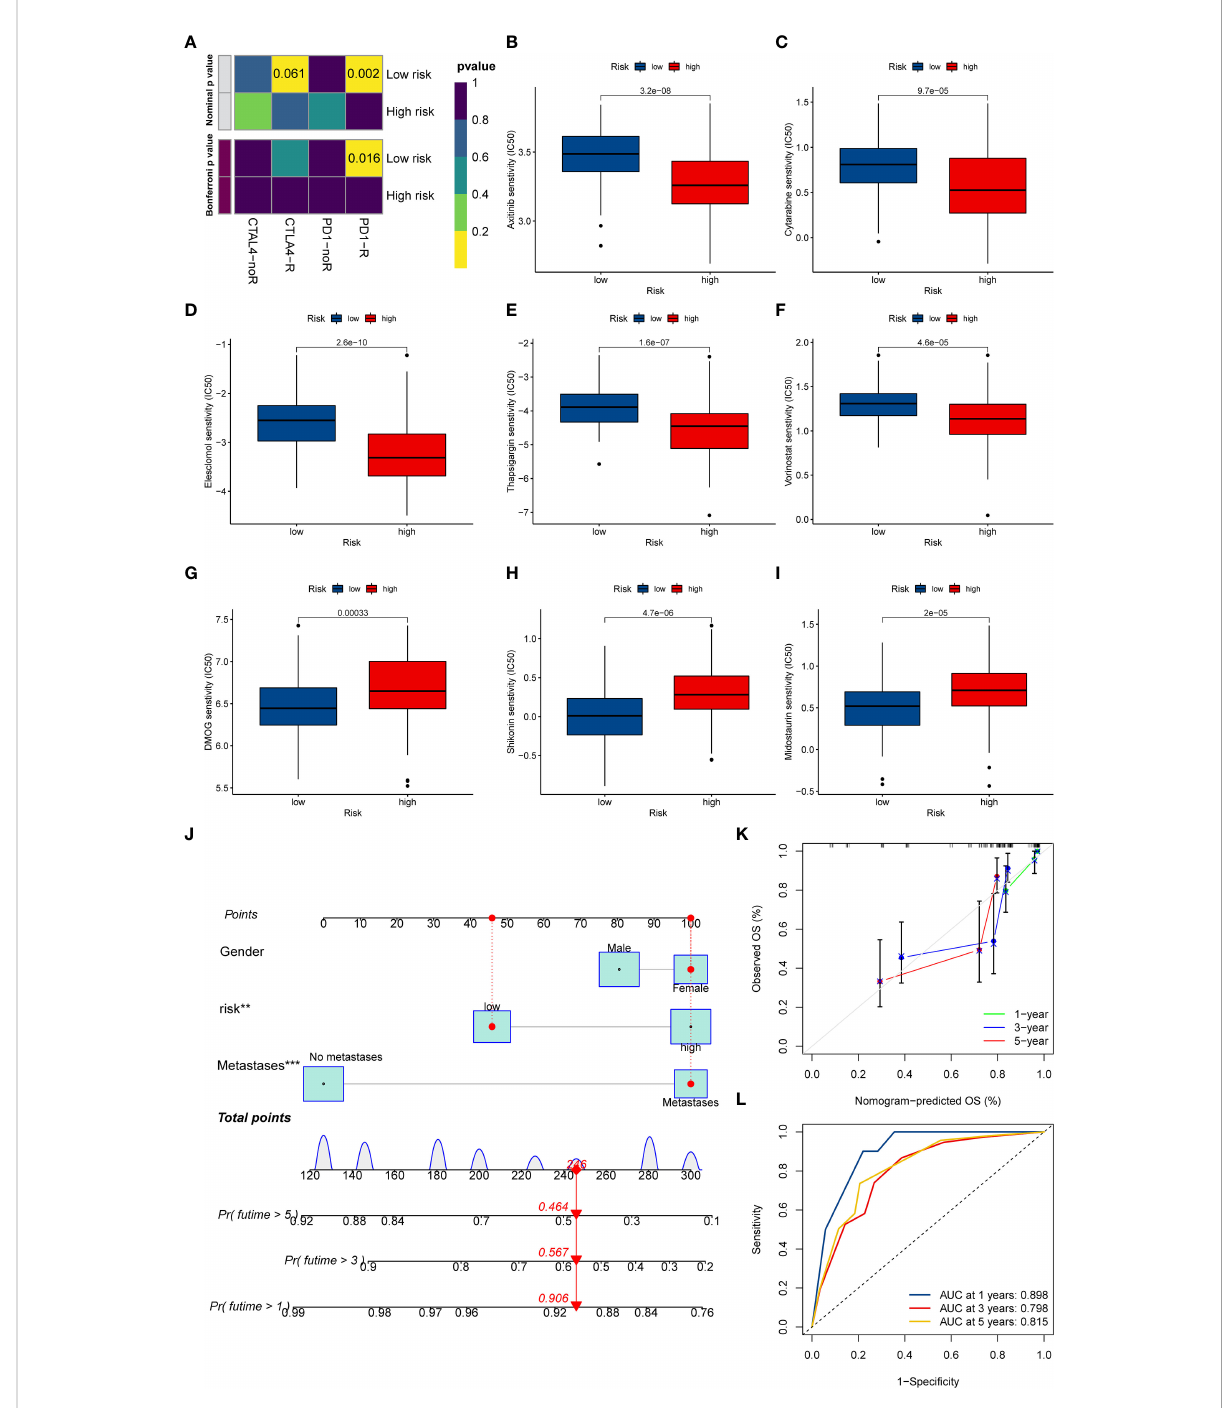
FIGURE 7 The potential clinical application of the novel signature. (A) Sensitivity prediction of OS patients with different ICD risk scores to the two immune checkpoint inhibitors. noR represent No response, and R represents the response. (B – I) Relationships between ICD risk score and chemotherapeutic sensitivity. (J) Nomogram based on the ICD risk score for predicting 1-, 3-, and 5-year survival rates of OS. (K) Calibration curves of the nomogram for predicting 1-, 3-, and 5-year survival rates. (L) ROC curves for predicting the 1-, 3-, and 5-year nomogram. ICD, Immunogenic cell death; OS, Osteosarcoma; ROC, Receiver operating characteristic. **p < 0.01, ***p <